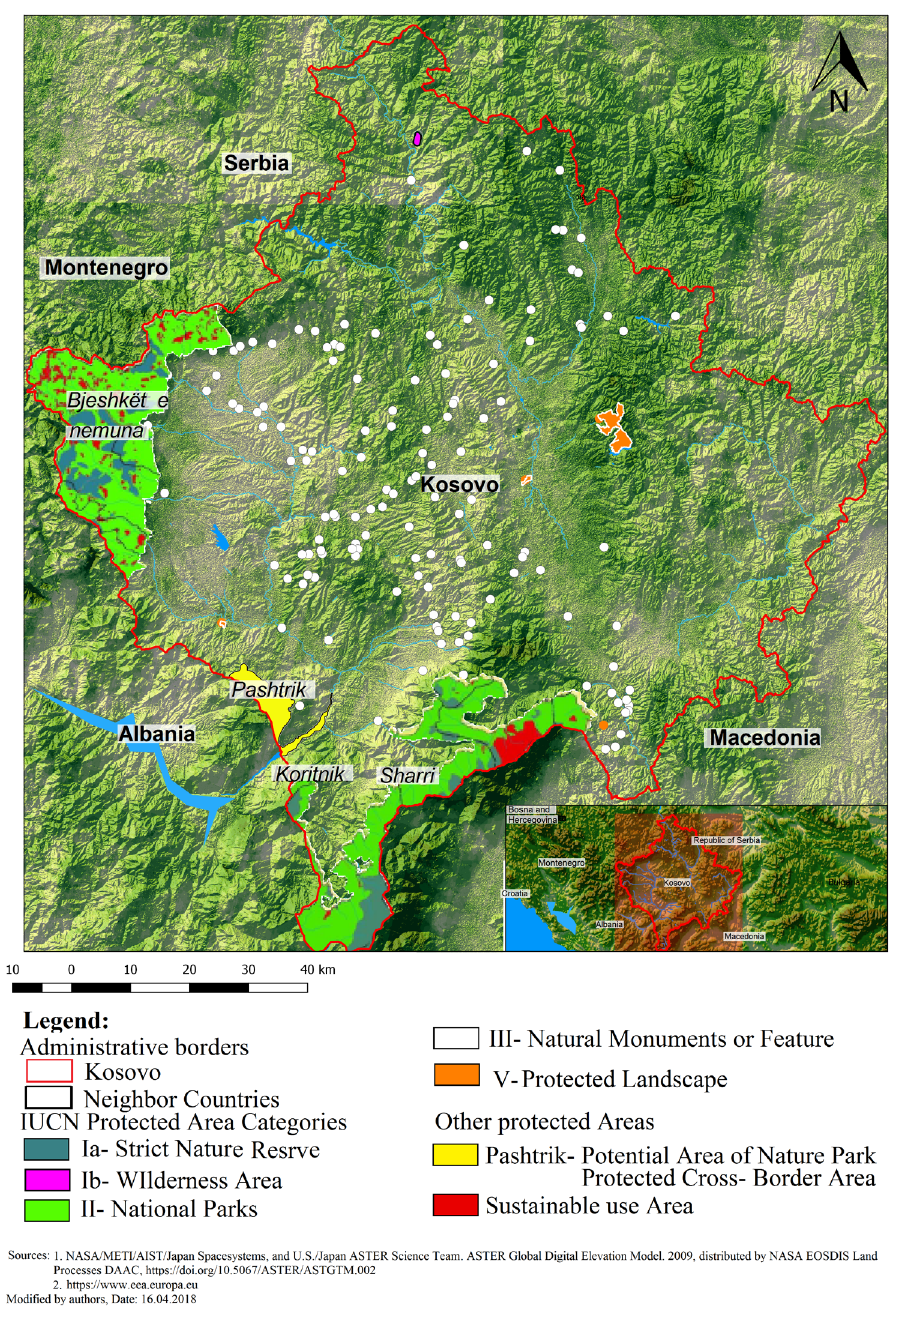
Figure 4: Map of the existing protected areas in